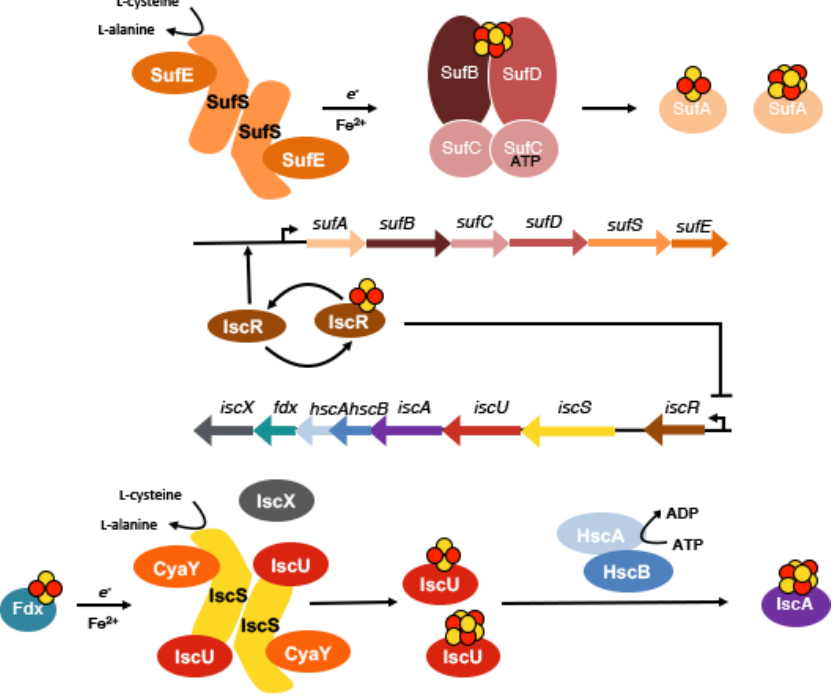
Figure 3. A model for the assembly of Fe-S clusters in E. coli by the ISC and SUF machinery. For each system, the proteins involved in each step are indicated in addition to their operon organization. The building of the Fe-S clusters in both systems is facilitated by the scaffold proteins IscU or SufB. After the formation of [2Fe-2S] or [4Fe-4S] clusters on IscU, their release is catalyzed with the help of the HscBA co/chaperones in the ISC system. This step in particular still needs to be clarified in the SUF machinery. After formation, the clusters are transferred by the A-type carrier proteins IscA and SufA to target proteins. Both systems are tightly regulated by IscR at the level of Fe-S cluster availability. Under normal conditions, the IscR regulator exists in an [2Fe-2S] cluster bound form and represses its own expression to control Fe-S cluster formation and the Fe-S state of the cell. Under iron limitation, the IscR regulator is accumulated and converted to its apo-form that activates the suf operon. The model shows a simplified version of the regulation of both systems, not depicting the regulation by small RNAs or oxygen.